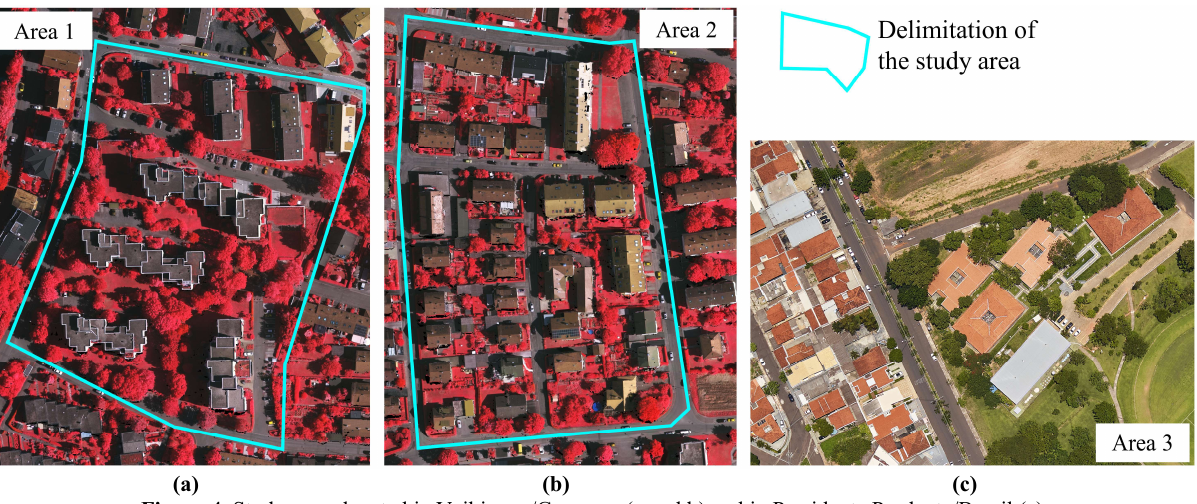
Figure 4. Study areas located in Vaihingen/Germany (a and b) and in Presidente Prudente/Brazil (c).